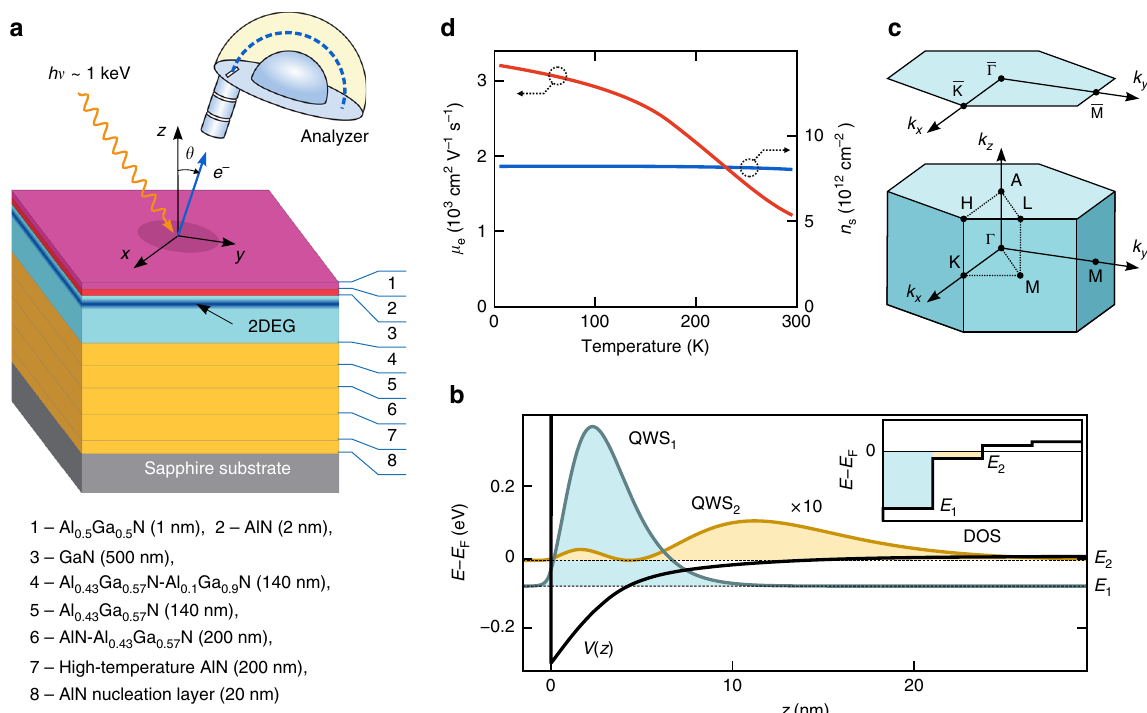
Fig. 1 SX-ARPES experiment on the GaN-HEMT heterostructure. a Scheme of the epitaxial GaN-HEMT samples investigated by SX-ARPES. The ð E ; ϑ Þ of the photoelectron kinetic energy E ϑ , which yield the binding energy E photoelectron analyser detects the distribution I k and emission angle B and PE k momentum k back in the sample (corrected for the photon momentum p = hv / c ) to produce the sought-for electron dispersions E ( k ). b T -dependence of n s and μ e obtained from Hall measurements. c Sketch of the electronic structure based on self-consistent solution of the 1D Poisson-Schrodinger equation. The quasi-triangular 1D potential V ( z ) con fi nes two QWSs having different spatial localization of their electron density n i ( z ) (exaggerated by × 10 for the QWS 2 ) centered at ~ 3 and ~ 12 nm for QWS 1 and QWS 2 , respectively. The total three-dimensional DOS (insert) show steps characteristic of the 2D